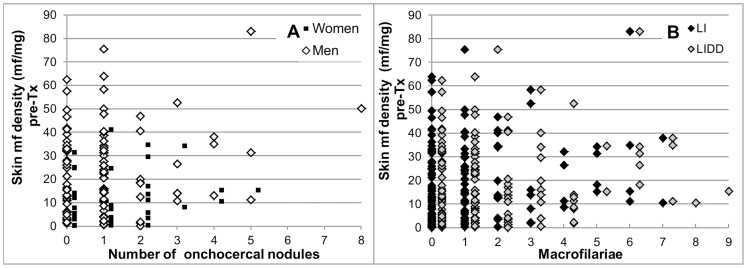
A. Skin microfilaria density pre-treatment by sex of participant and number of onchocercal nodules.B. Skin microfilaria density pre-treatment by number of live female macrofilariae and sum of live (LI) and dead, non-calcified female macrofilariae (LIDD). Only data from participants who had not more palpable nodule sites at month 18 than at pre-treatment and who had agreed to excision of all palpable nodules or who had no palpable nodules are included. For display reasons, the×axis maximum in Figure B was set to 9. The data from the man with 8 nodules in Figure A who had 13 live female macrofilariae and 3 dead, non-calcified female macrofilariae and 50.2 mf/mg skin pre-treatment are thus not displayed.